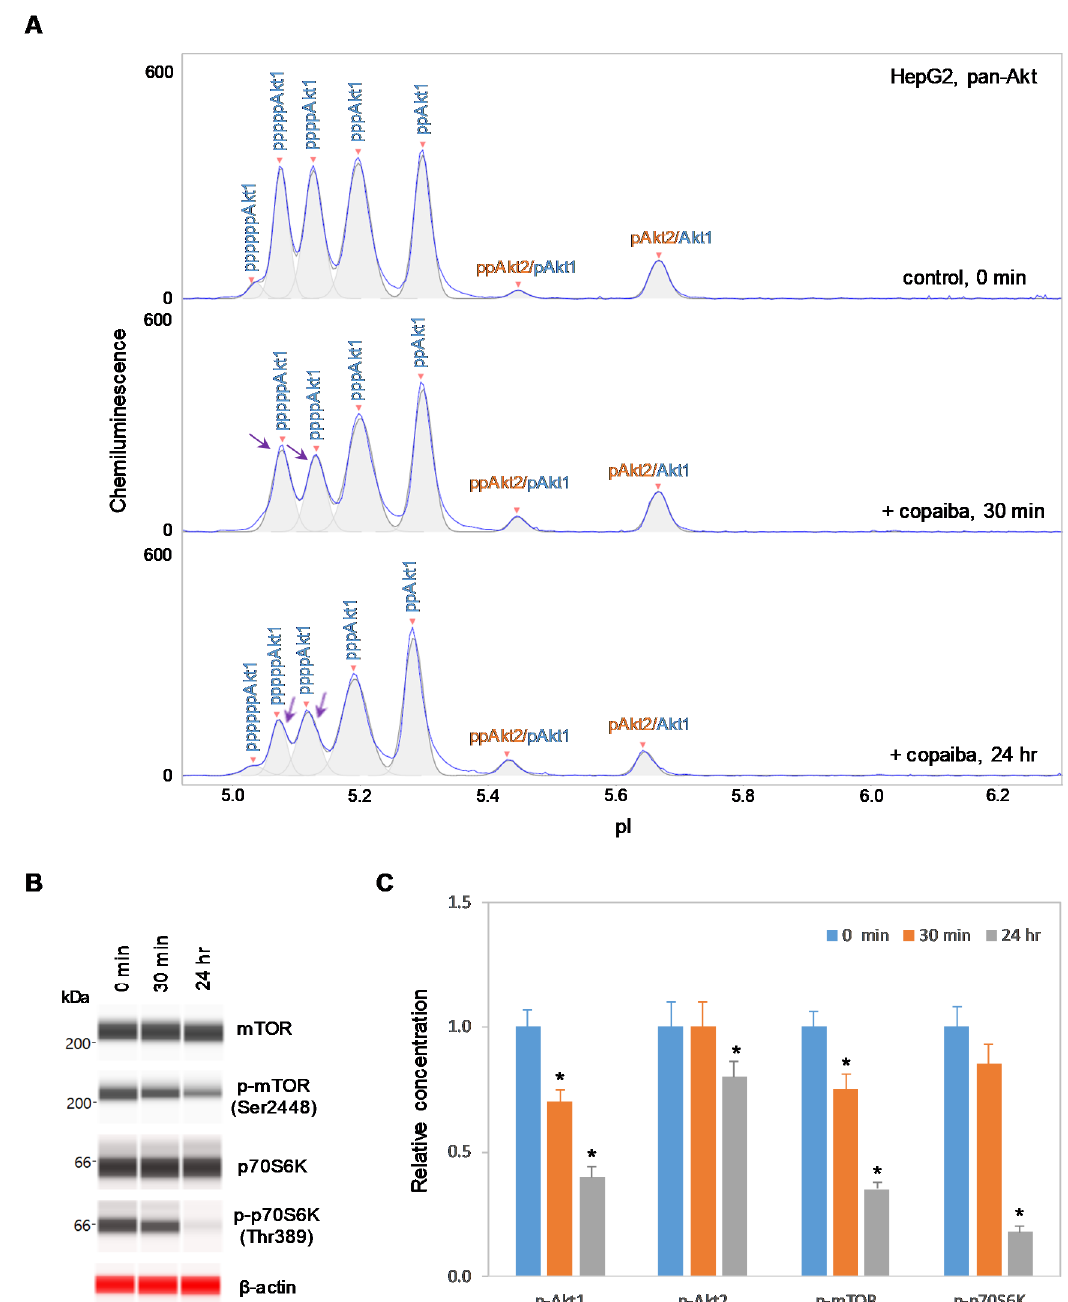
Figure 4. Negative regulation of the pI3K/Akt/mTOR signaling pathway in HepG2 liver cells by copaiba essential oil. ( A ) cIEF electropherograms of pan-Akt in HepG2 cells before (0 min) and after (30 min and 24 h) treatment with copaiba essential oil. Peaks associated with Akt isoforms are labeled and color-coded: Akt1 (blue) and Akt2 (orange). The purple arrows point to highly phosphorylated Akt1 peaks that exhibited a reduced amplitude following treatment with copaiba essential oil. ( B ) Expression levels of the mTOR and p70S6K phosphoisoforms as a function of time after treatment with copaiba essential oil. β-Actin serves as the loading control. ( C ) Relative concentrations of Akt1, Akt2, Akt3, mTOR, and p70S6K phosphoisoforms as a function of time after treatment with copaiba essential oil. The relative concentration describes the fold change in the expression level of a protein phosphoisoform after treatment compared to that under the control condition. The error bars indicate the standard deviations of six repeated measurements per experimental condition. The asterisks indicate a statistical significance of p ≤ 0.05 versus the control. HepG2 cells were treated with 100 ng/mL copaiba essential oil.